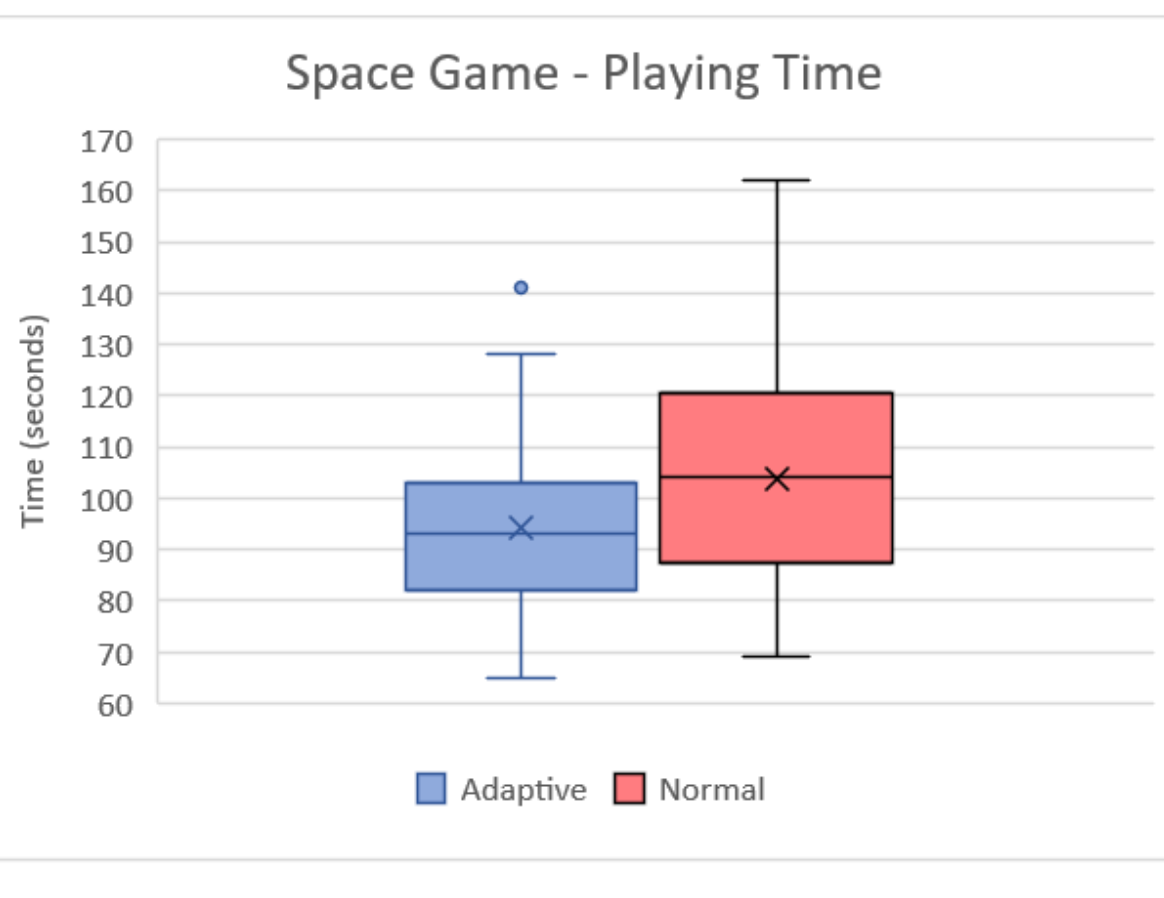
Figure 9. Box plot of correct answers for the Memory game from the second session with